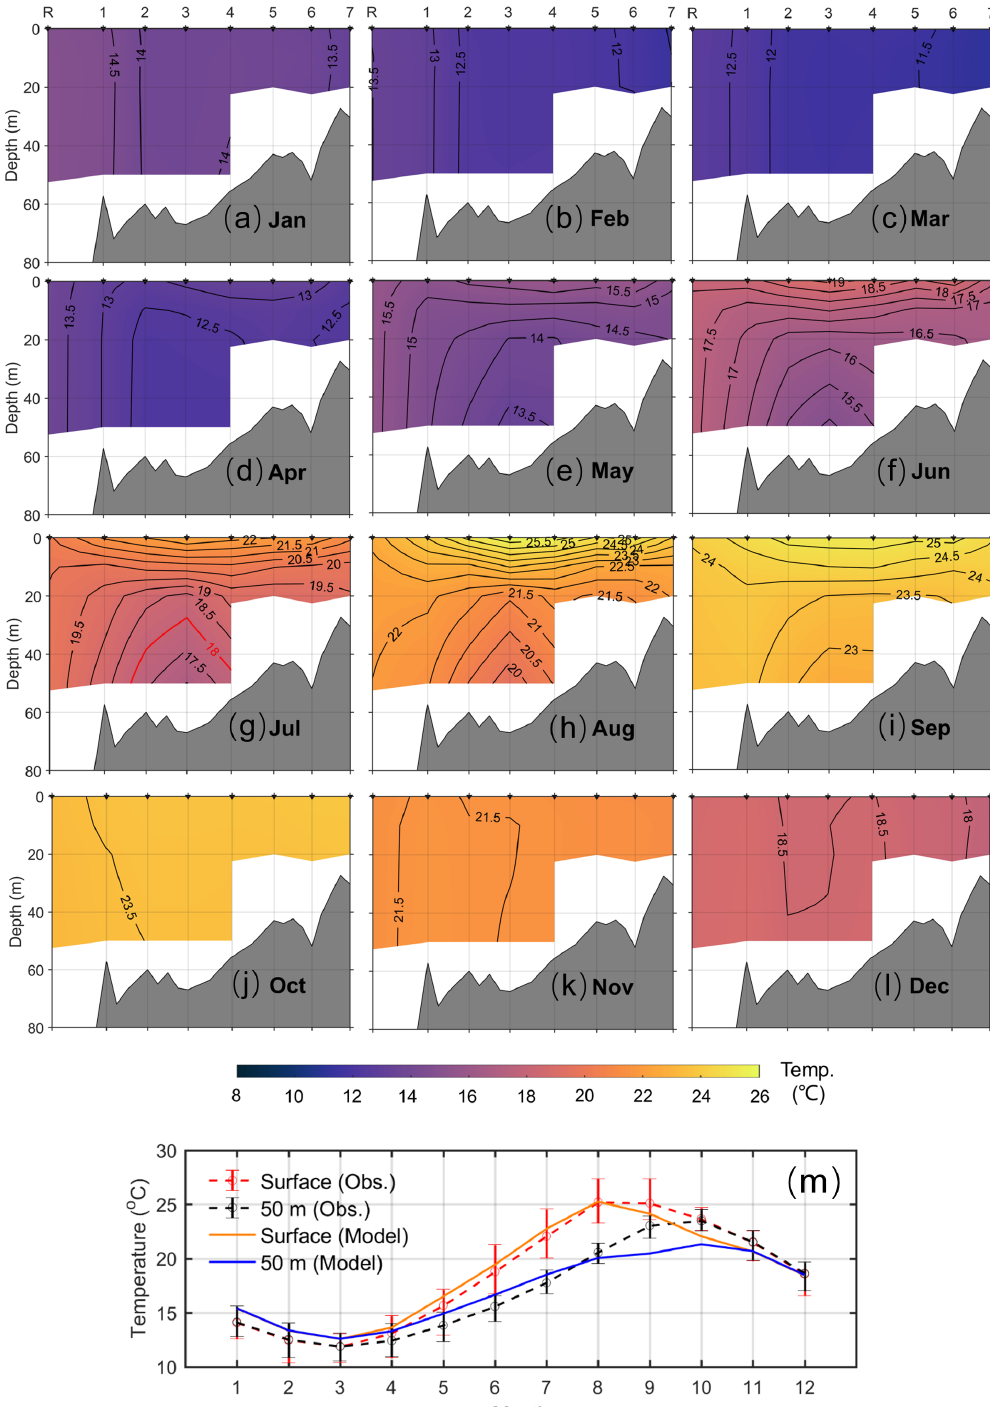
Figure 2. Spatial distributions of multi-year (1994–2015) averaged water temperature along a vertical transect (station R to station 7) from January to December (a–l) . (m) Time series of observed and simulated water temperatures averaged for stations 1–4 at the surface and 50m depth. The red line of the 18 ◦ C isotherm in (g) is used to define the Iyo-Nada bottom cold water mass (INCWM). The red and black bars in (m) represent the ranges of observed water temperatures at the surface and 50m depth,